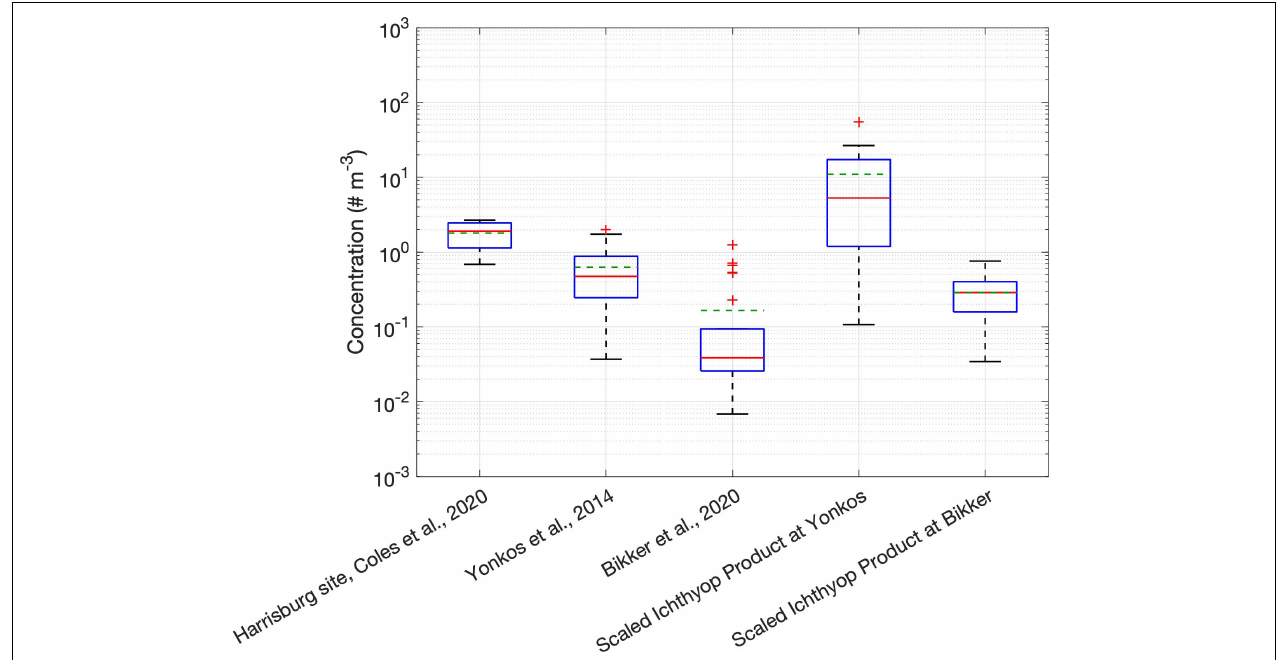
FIGURE 9 | Box plots of concentrations from three observational studies, as well as scaled model concentrations from the same bay locations used in Yonkos et al. (2014) and Bikker et al. (2020). Green dashed lines denote the mean, while red denotes the median. Scaling was done by taking the 7-day model mean centered on the date of observation, then multiplying the model concentration for each observation by the ratio between the median of the observed concentration at the Harrisburg USGS station from the Coles et al. (2020) dataset and the concentration of particles (1.157 × 10 − 5 m − 3 ) added to the particle tracking model. Note there is no Scaled Ichthyop Product for the Coles et al. (2020) dataset, as the observation sites are either outside of the model domain or within the model